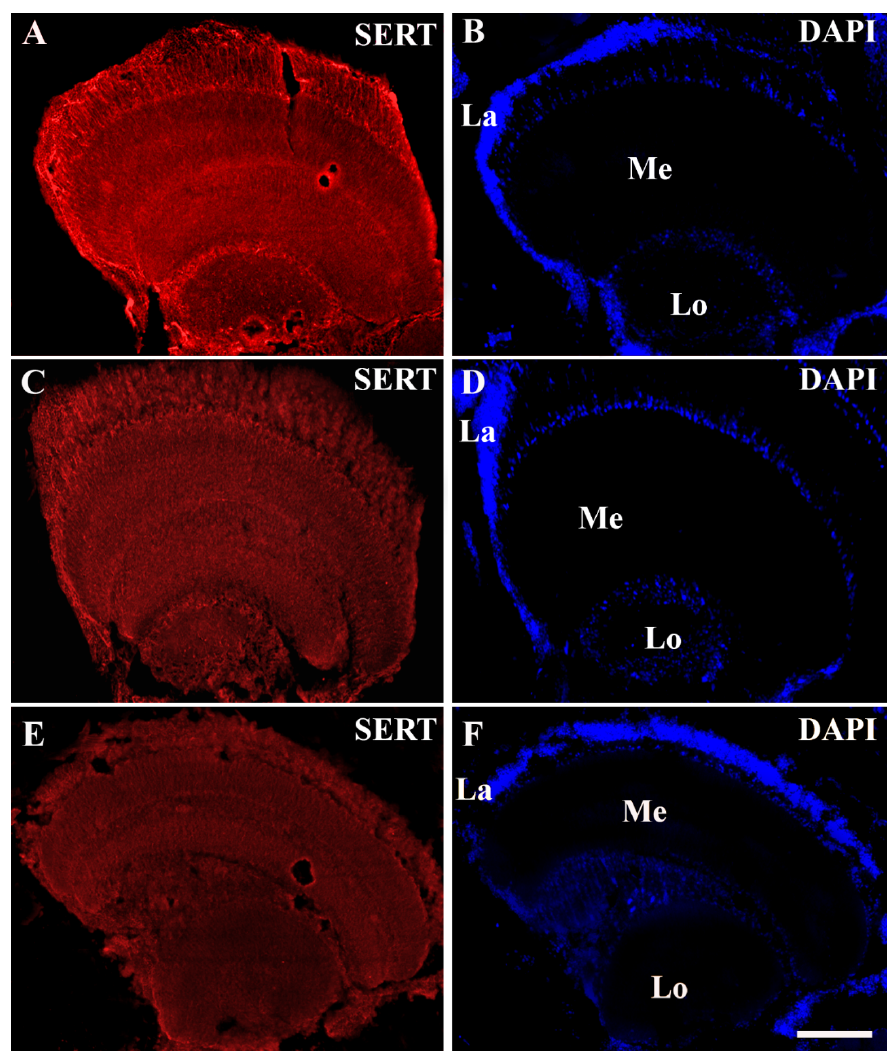
Figure 1. General appearance of serotonin transporter (SERT) immunoreactivity in the optic lobes of the docile ( A , B ), moderate ( C , D ) and aggressive ( E , F ) honeybees. Note that SERT immunoreactable 100 µ m. Abbreviations: La, lamina; Me, medulla; Lo,